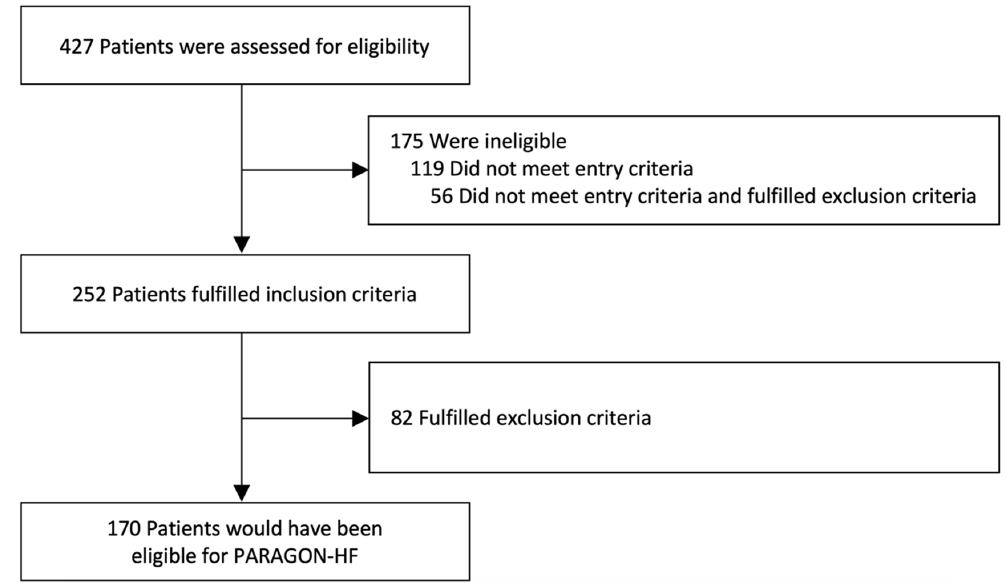
Figure 1. Flowchart showing hypothetical eligibility for PARAGON-HF. Patients ( n = 427) from a real-world HFpEF registry were tested for their hypothetical eligibility for PARAGON-HF.